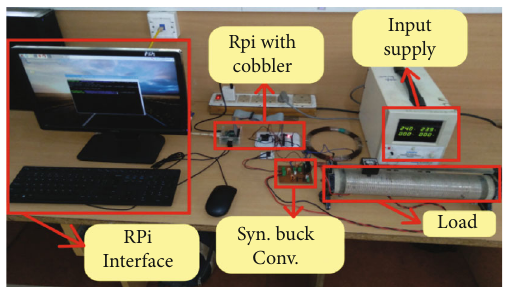
Figure 15: Experimental setup of